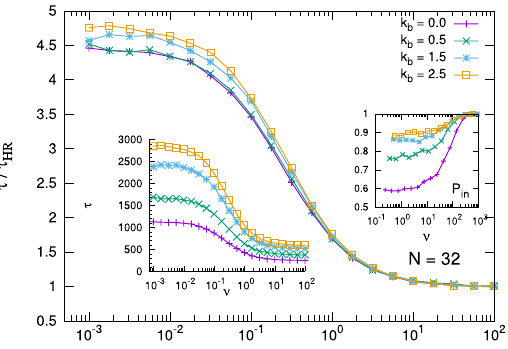
Figure 4. Mean translocation time τ normalized with its high rate limit τ HR value, for different values of the bending parameter k b , with k b = 0.0, 0.5, 1.5, 2.5, and N = 32. Right inset: translocation probability P in . Left inset: Mean translocation time (not normalized). The values at high rate are τ HR = 253, 374, 521, 599 time units, for the four bending values, respectively.